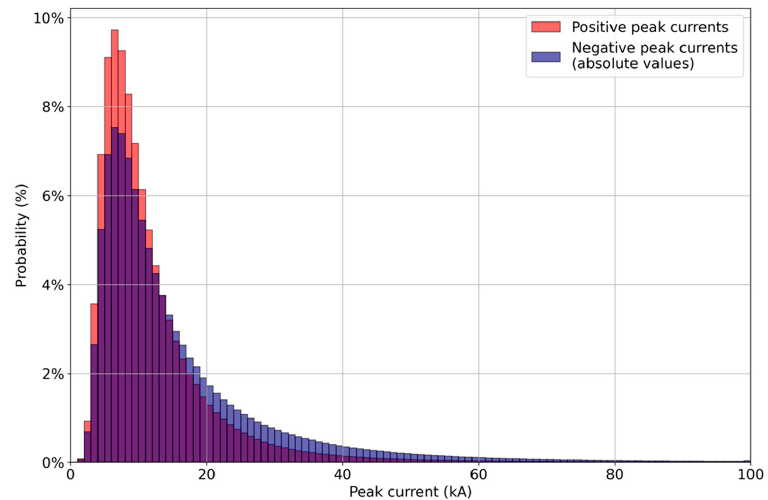
Figure 10. Distributions of peak current for positive (red) and negative (blue, as absolute values) flashes in Vietnam in 2015–2019. The x-axis is limited to 100 kA.